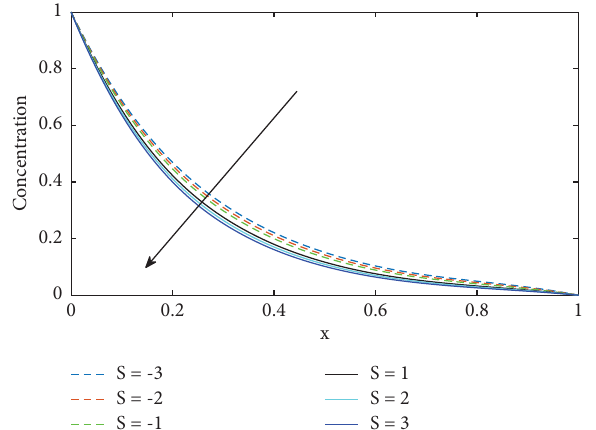
Figure 9: Concentration profles for diferent values of S .